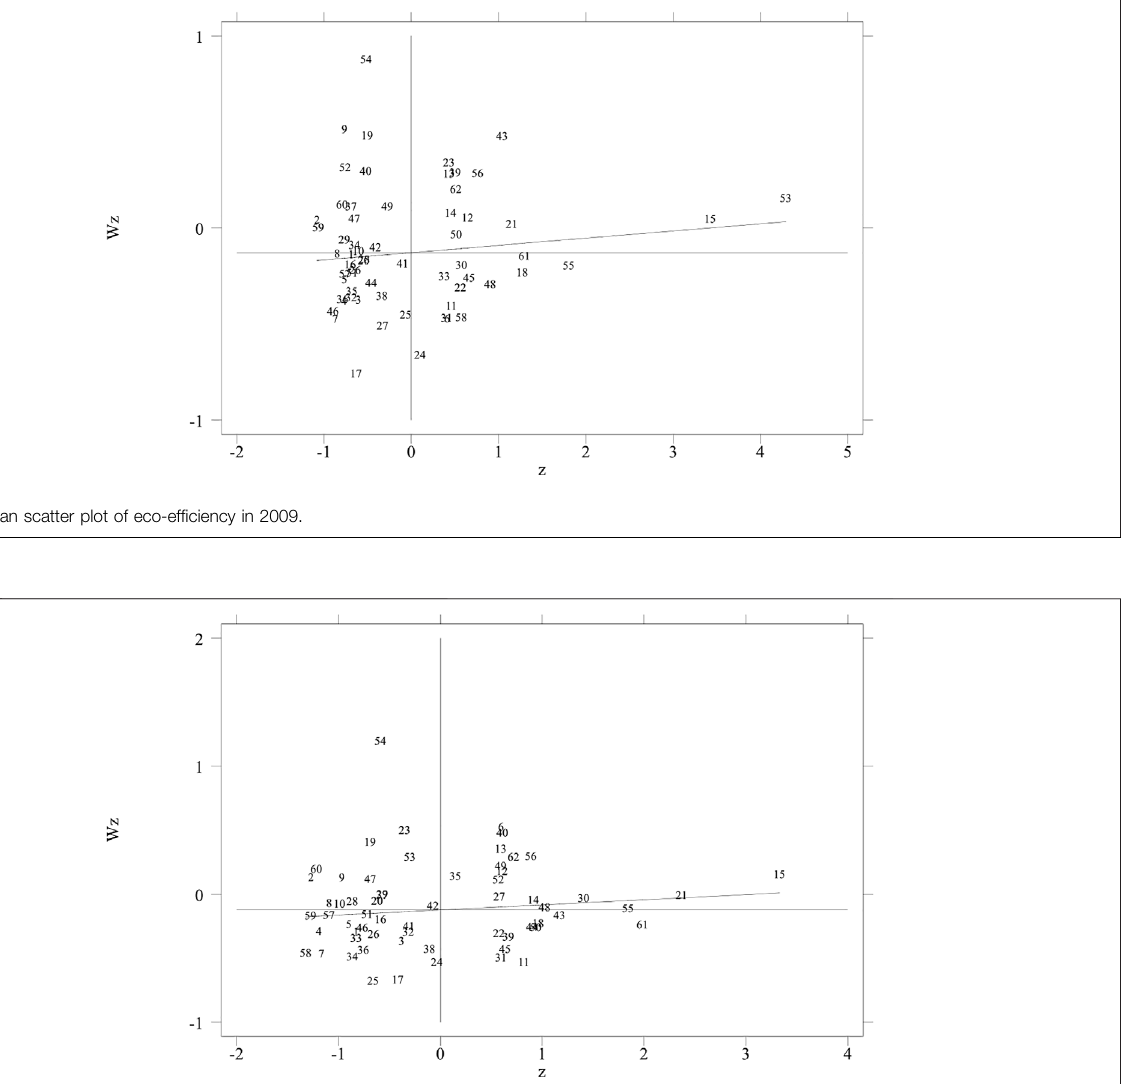
FIGURE 6 | Moran scatter plot of eco-ef fi ciency in